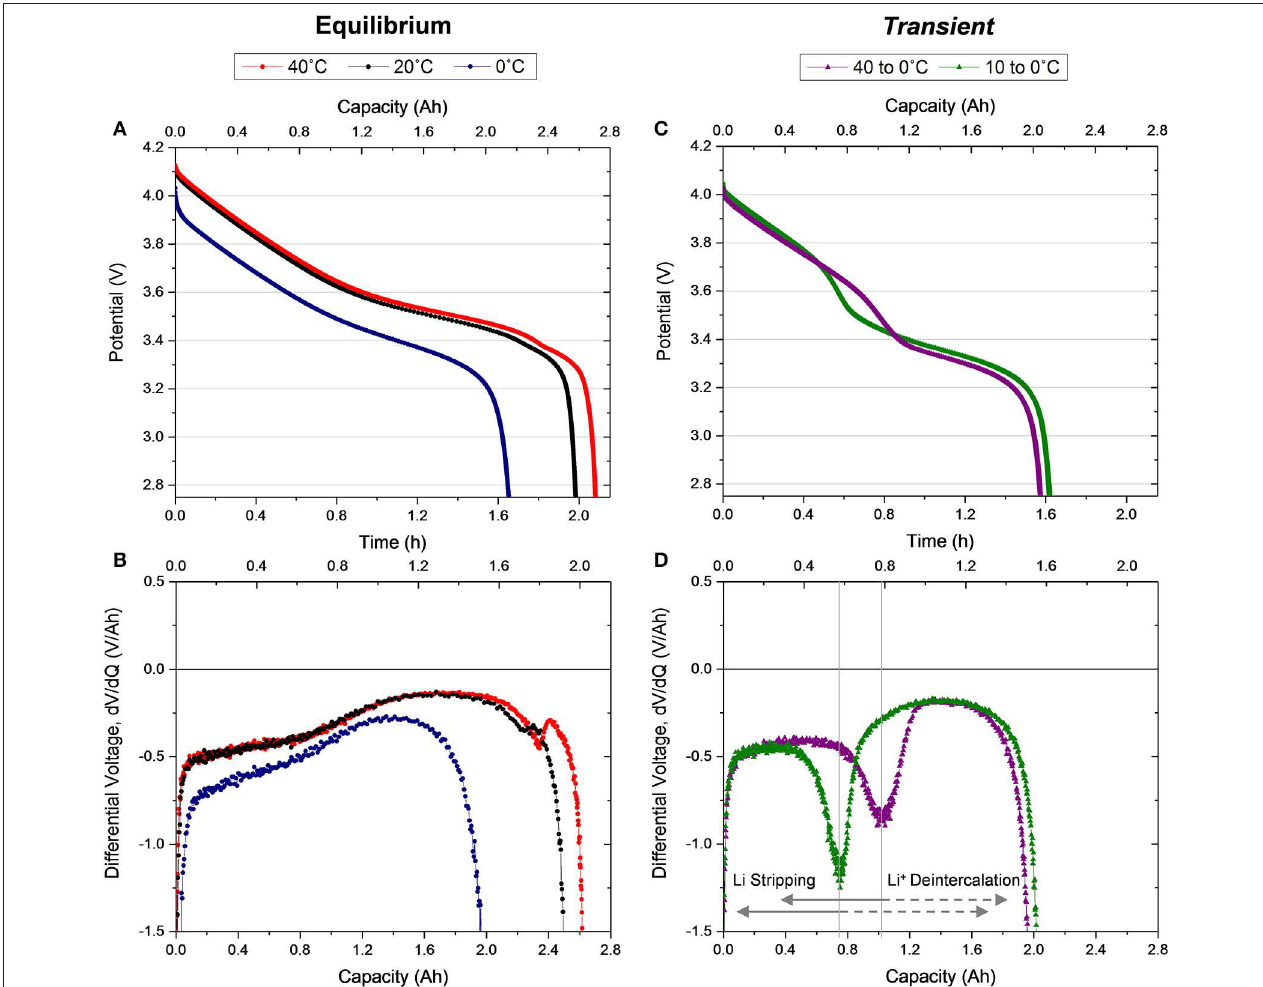
FIGURE 3 | (A) Voltage profiles and (B) differential voltage for the first C/2 galvanostatic discharge immediately following the first charge for Equilibrium 40, 20, and 0 ◦ C cells. (C) Voltage profiles and (D) differential voltage for the first C/2 galvanostatic discharge immediately following the first charge for Transient 40 to 0 ◦ C and 10 to 0 ◦ C